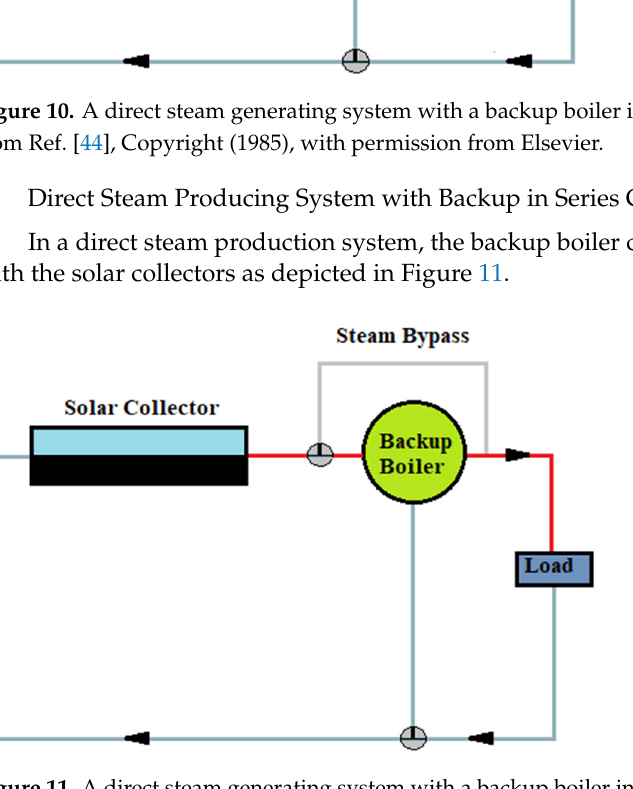
Figure 11. A direct steam generating system with a backup boiler in series connection. Adapted from Ref. [44], Copyright (1985), with permission from Elsevier.